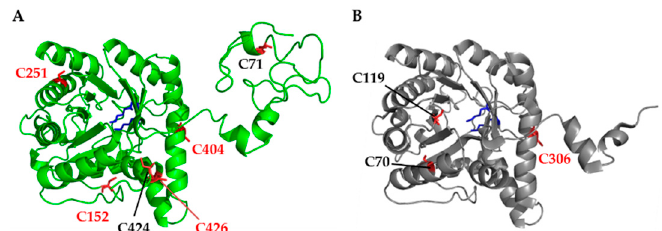
Figure 1. Comparative analysis of the X-ray 3D structure of Chlorobium vibrioforme 5-aminolevulinic acid dehydratase (ALAD) and the modelled ALAD from Arabidopsis thaliana . ( A ) The structure of mature Arabidopis ALAD was visualized with PyMOL (Schrödinger) after structure prediction with Phyre2. The modeled structure shows high structural homology with the two X-ray structures of the Mg 2+ dependent ALADs from Pseudomonas aeruginosa [32,33] and Chlorobium vibrioforme [34,35]. ( B ) The Chlorobium vibrioforme ALAD structure based on RCSB protein data bank (PDB) entry 1W1Z [34]. Cysteines are highlighted by red sticks, conserved cysteines in higher plants are highlighted in red lettering. The two Schiff base lysine residues (for A. thaliana K298 and K351) are highlighted in the two structures by blue sticks.